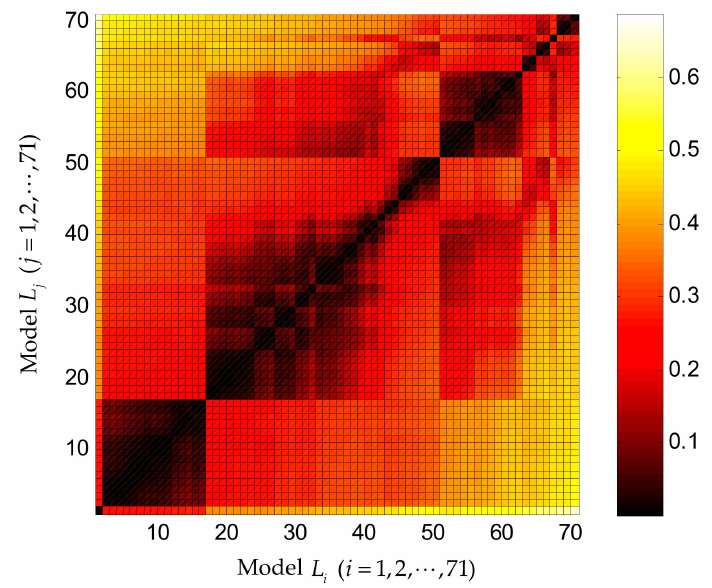
Figure 5. The matrix of the gap metric between the gas turbine linearized models.